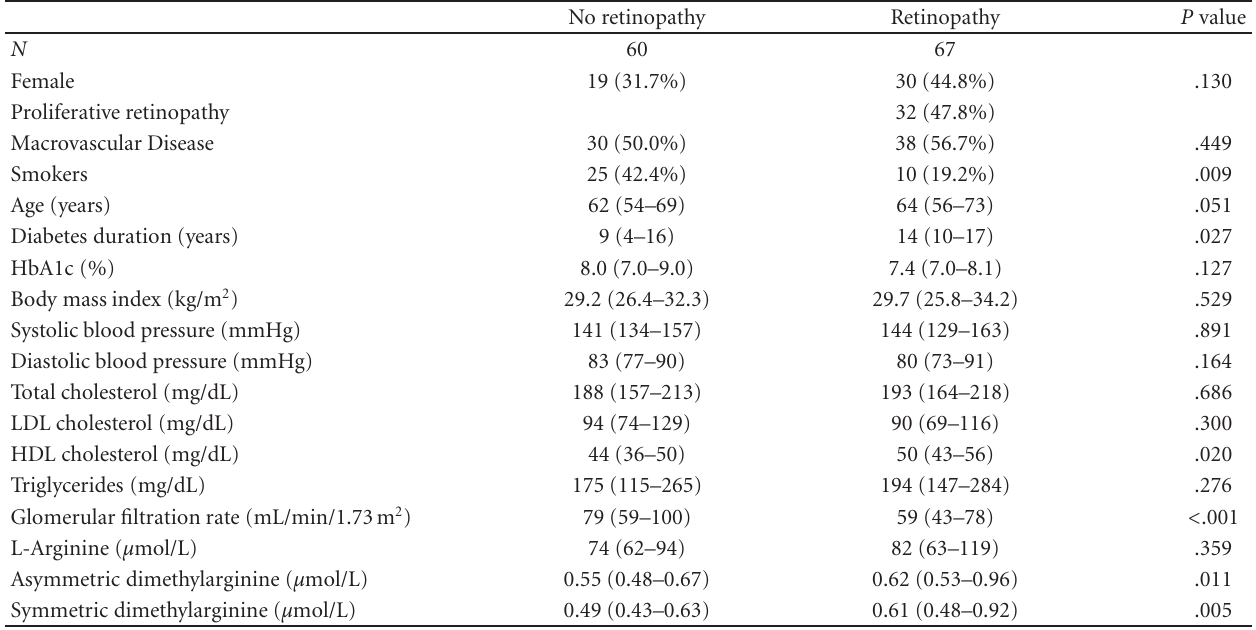
Table 1: Characteristics, L-Arginine, and asymmetric and symmetric dimethylarginine according to the prevalence of diabetic retinopathy.